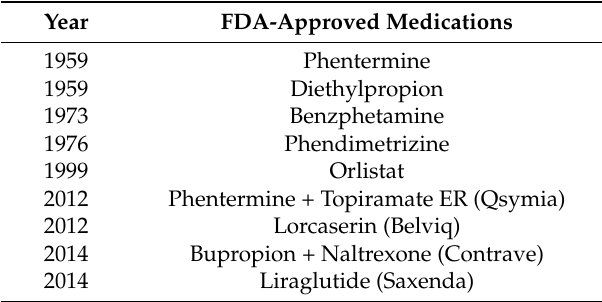
Table 1. FDA approved anti-obesity